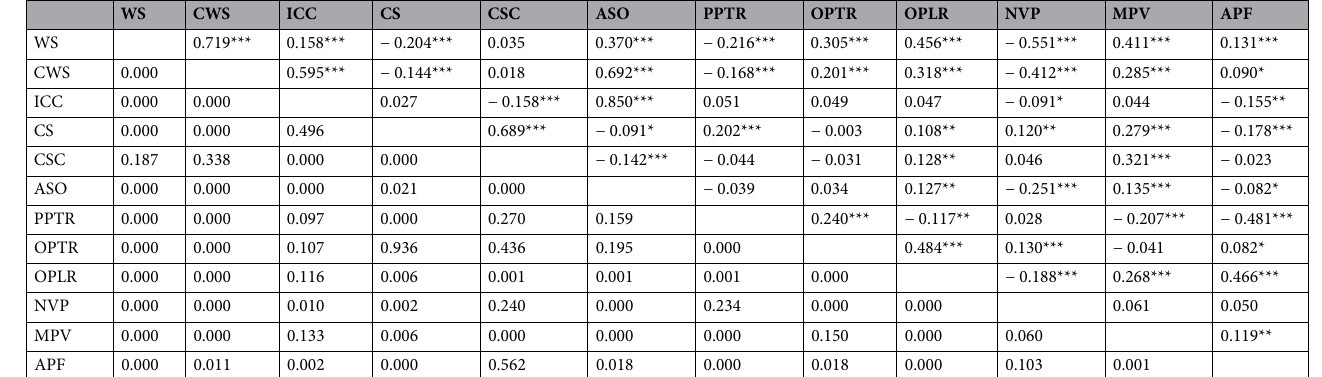
Table 3. Cross correlation among the computerized measures (N = 641). WS Writing speed, CWS Correct writing speed, ICC Intra-character configuration, CS Character size, CSC Character size consistency, ASO Accuracy of stroke order, PPTR Pen pause time ratio, OPTR On-paper time ratio, OPLR On-paper length ratio, NVP Number of velocity peak per stroke, MPV Mean peak velocity, APF Axial pen force. * p < 0.05, ** p < 0.01, *** p < 0.001.